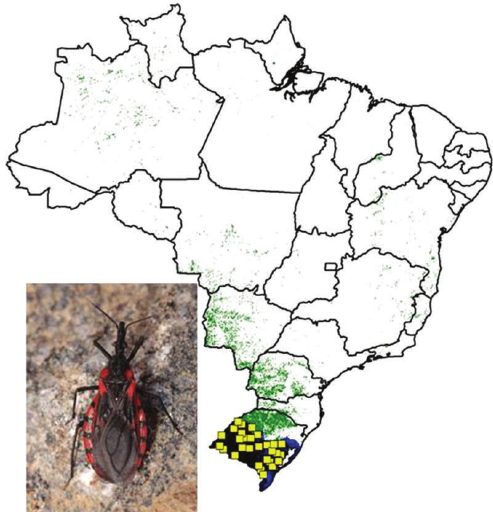
Figure 6: Ecological niche models projected as potential distribu- tion for T. rubrovaria